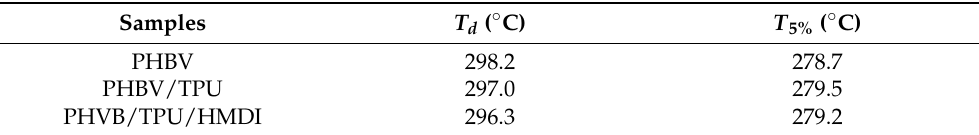
Figure 3. The TGA and DTG curves of the neat PHBV, PHBV/TPU and PHBV/TPU/HMDI blends. Table 2. The TGA parameters.